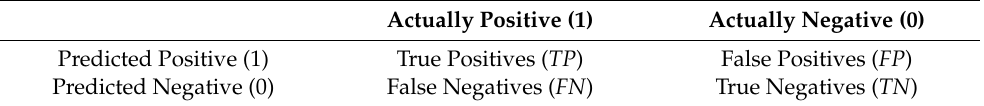
Table 1. Confusion